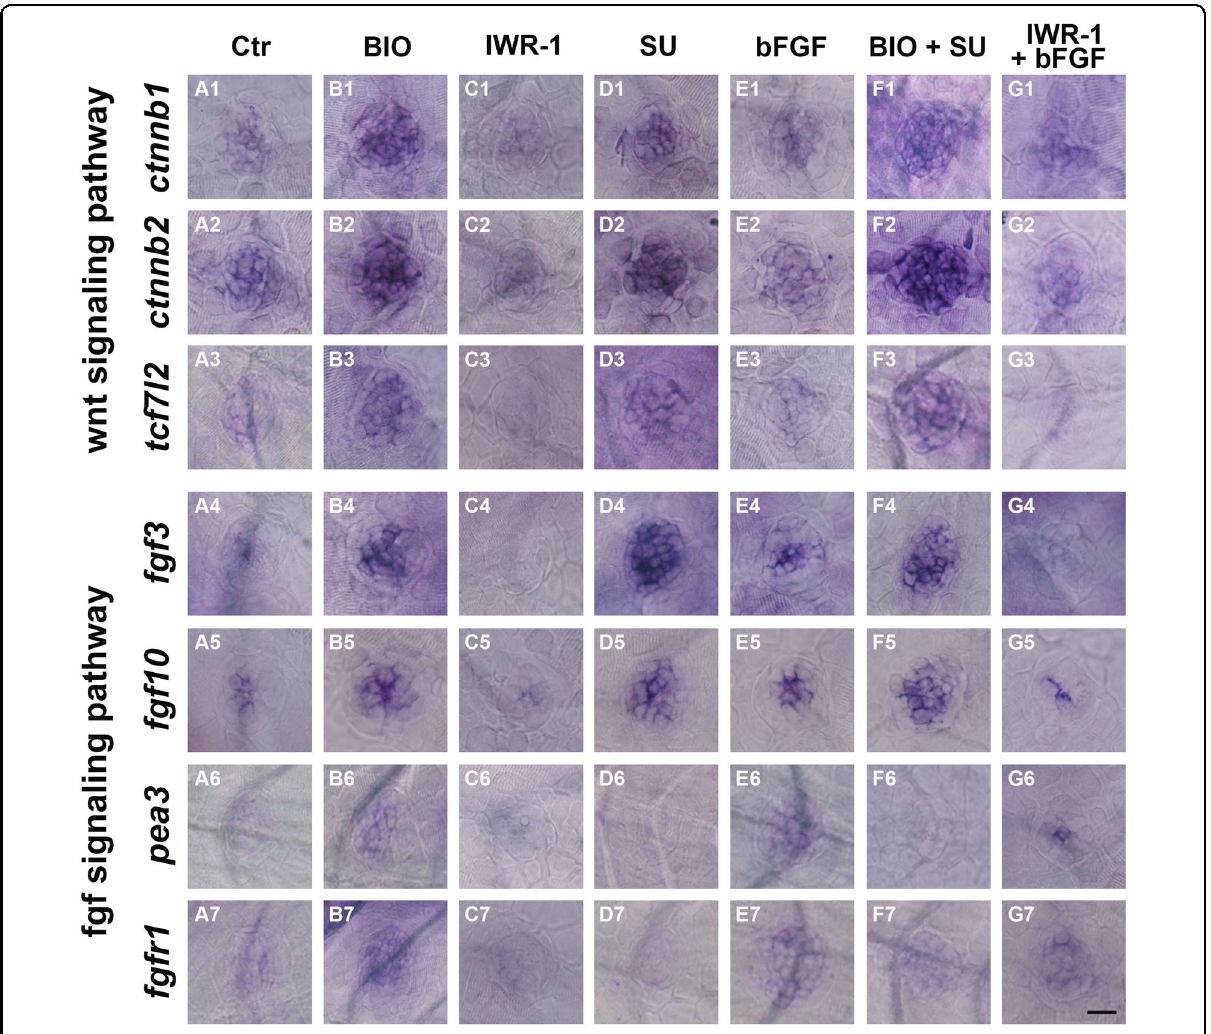
Fig. 6 Whole-mount in situ hybridization of several Wnt and FGF target genes following regulation of Wnt and FGF signaling. In situ hybridization of ctnnb1 ( A1 – G1 ), ctnnb2 ( A2 – G2 ), tcf7l2 ( A3 – G3 ), fgf3 ( A4 – G4 ), fgf10 ( A5 – G5 ), pea 3 ( A6 – G6 ), and fgfr1 ( A7 – G7 ) following BIO ( B1 – B7 ), IWR-1 ( C1 – C7 ), SU5402 ( D1 – D7 ), bFGF ( E1 – E7 ), BIO + SU5402 ( F1 – F7 ), and IWR-1 + bFGF ( G1 – G7) treatments. Scale bar in G7 = 30 μ m for A1 –